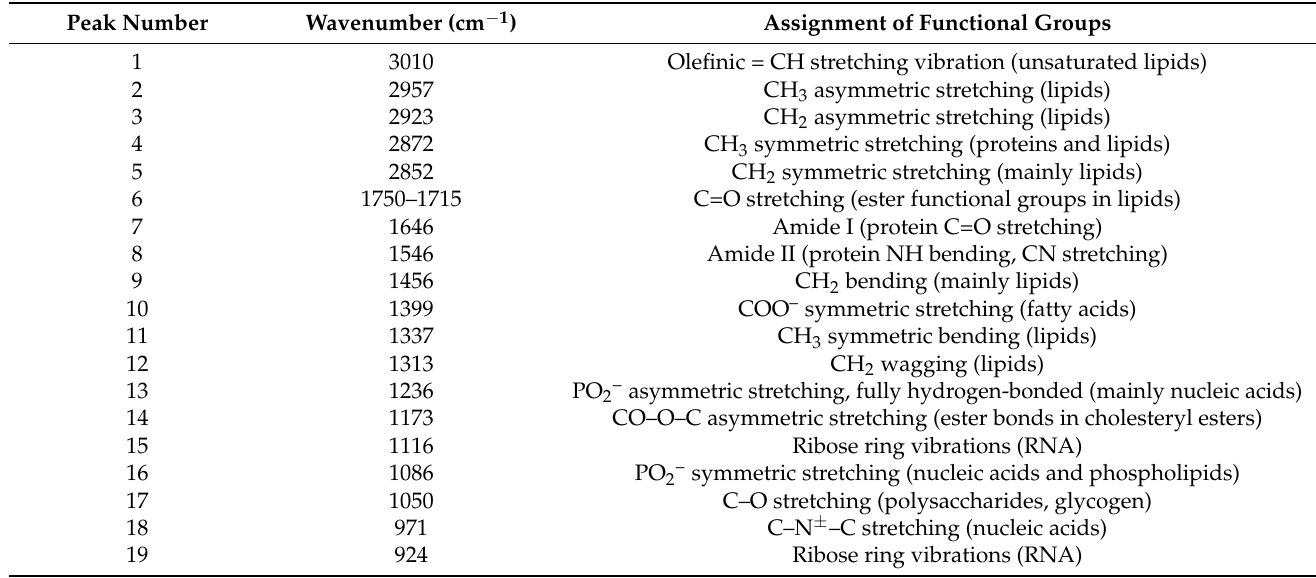
Table 1. Band Assignments of the Main Peak Absorption of Cells in the 3050–900 cm − 1 IR Spectral Region